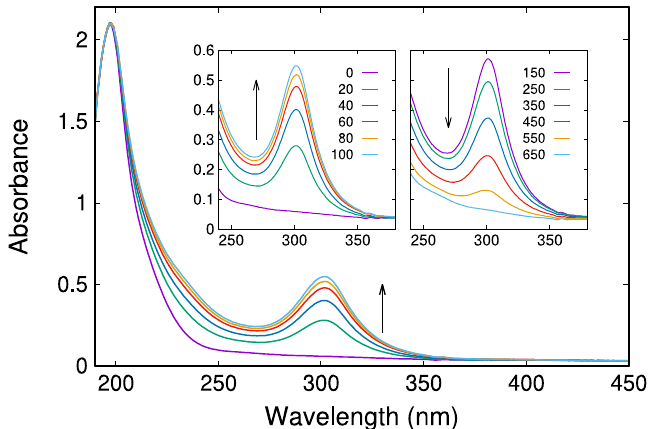
Figure 2. UV absorption spectra of a reaction solution initially containing 300 µ M Cu 2+ and 300 µ M NAC in 40 mM HClO 4 recorded at the given times in minutes (insets) from the beginning of the reaction. The records were acquired on the diode array spectrophotometer with a scan period of 20 s (shutter on) at 20 °C.